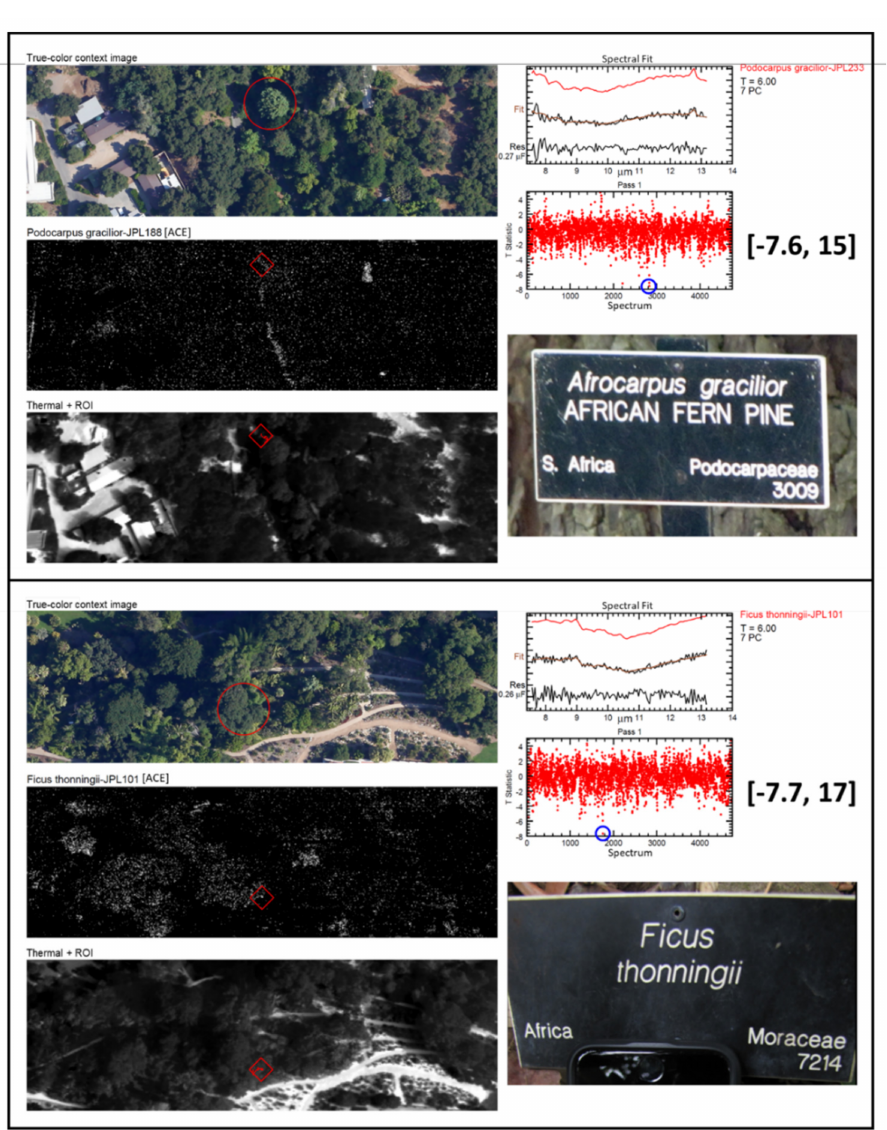
Figure 8. Two examples of weak positive IDs. Upper panel: Afrocarpus gracilior (syn. Podocarpus gracilior ), lower panel: Ficus thonningii . GSD: 0.5